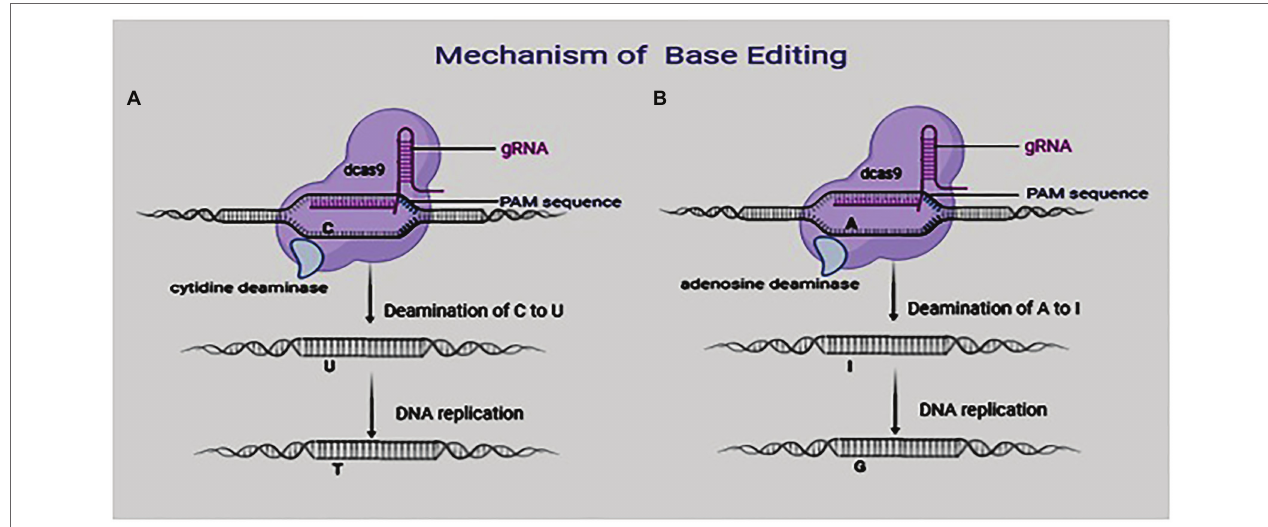
FIGURE 1 | Mechanism of base editing system: (A) Base editing using cytosine base editors (CBEs) and (B) base editing using adenosine base